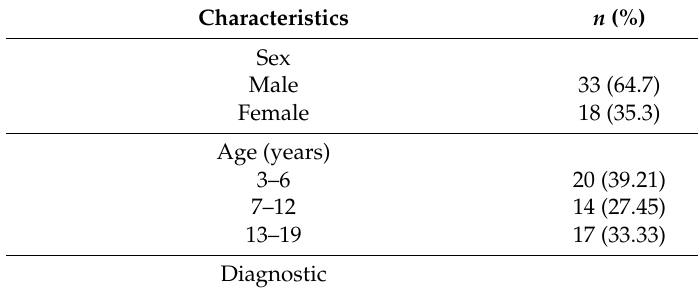
Table 2. Distribution of oncopediatric patients according to demographic and clinical